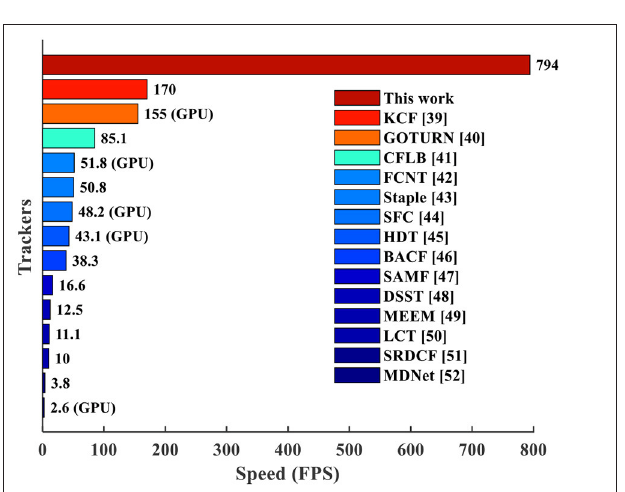
FIGURE 15 | Speed comparison with existing tracking algorithms (Danelljan et al., 2014a,b, 2015; Zhang et al., 2014; Galoogahi et al., 2015, 2017b; Henriques et al., 2015; Ma et al., 2015; Wang L. et al., 2015; Bertinetto et al., 2016a,b; Nam and Han, 2016; Qi et al., 2016). The data marked with “(GPU)” are tested on GPU while others are on CPU.